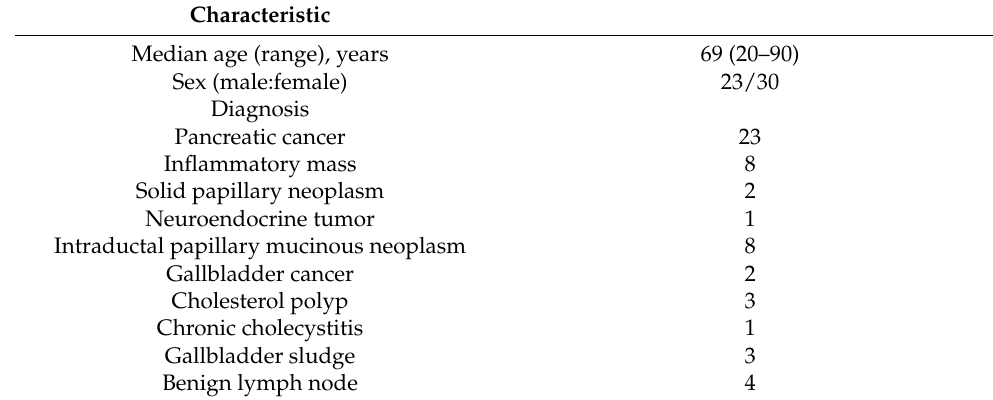
Table 1. Patient characteristics.